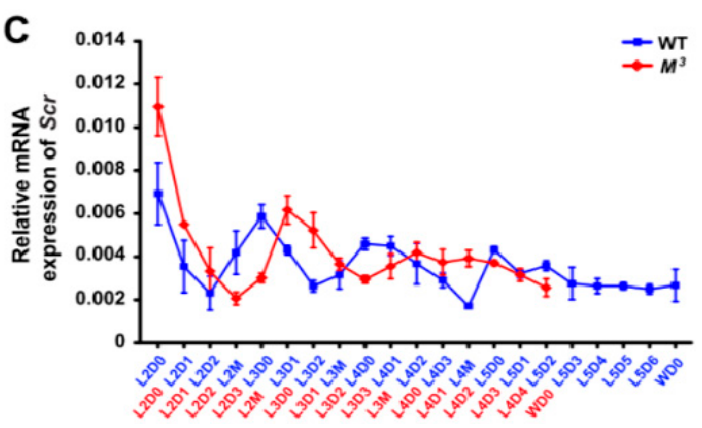
Figure 5. Developmental expression of the Scr gene in the M 3 and WT larvae. ( A , B ) qRT-PCR analysis of Scr expression in the Br-CC-CA complex. The results indicated that Scr was highly expressed in the Br-CC-CA complex in the early stages of either the fourth instar of WT larvae or the third instar of M 3 larvae, and that it was dramatically decreased in the final instar. This expression of the Scr gene exhibited a close correlation with the JH titer changes during the same stages; ( C ) qRT-PCR analysis of Scr expression in the areas of the head that mainly contain the Br-CC-CA complex. The results confirmed that the Scr expression levels in the head were higher in the M 3 larvae than in the WT larvae during the early feeding stage of the second instar, and these levels exhibited a positive correlation with the difference in the JH titers between the M 3 and WT larvae. L, larval instar; L2 to L5 respectively represents the second to the fifth larval instar; D, day; D0, initial day; D1 to D6 respectively represents the first to the sixth day of a larval instar; M, molting; W, wandering. The error bars represent the mean ˘ S.E. ( n =